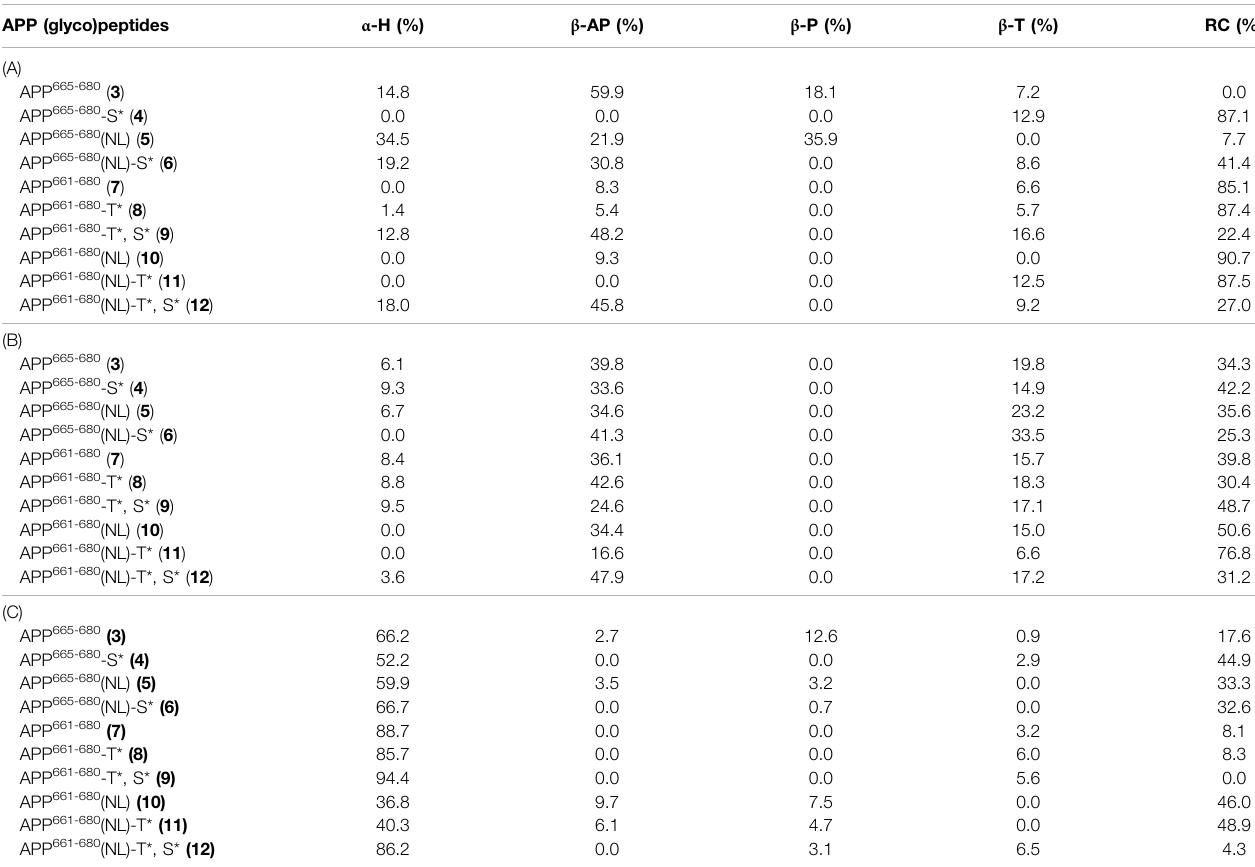
TABLE 2 | Summary of the secondary content (%) present in APP (glyco)peptides 3 – 12 determined by BeStSel for CD spectra obtained in (A) water (B) 10 mM sodium phosphate buffer, pH 7.4, and (C) TFE/water = 1:1 (v/v) a . APP (glyco)peptides α -H